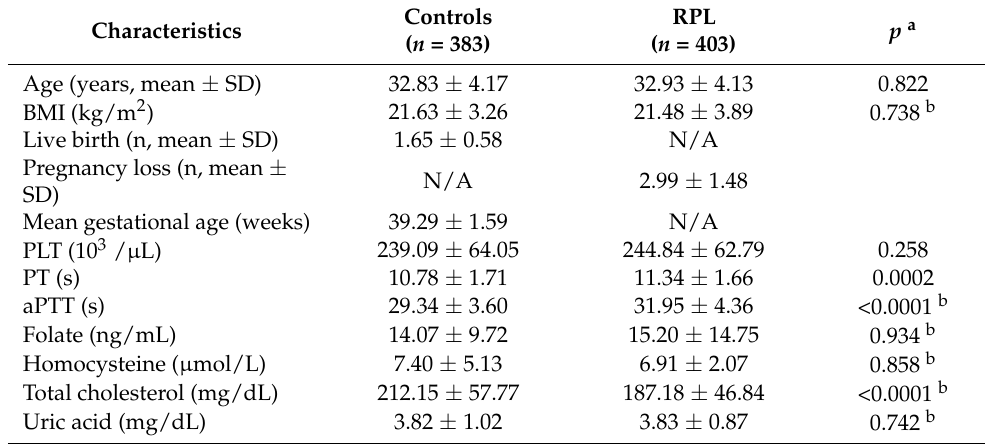
Table 1. Baseline characteristics between patients with recurrent pregnancy loss (RPL) and